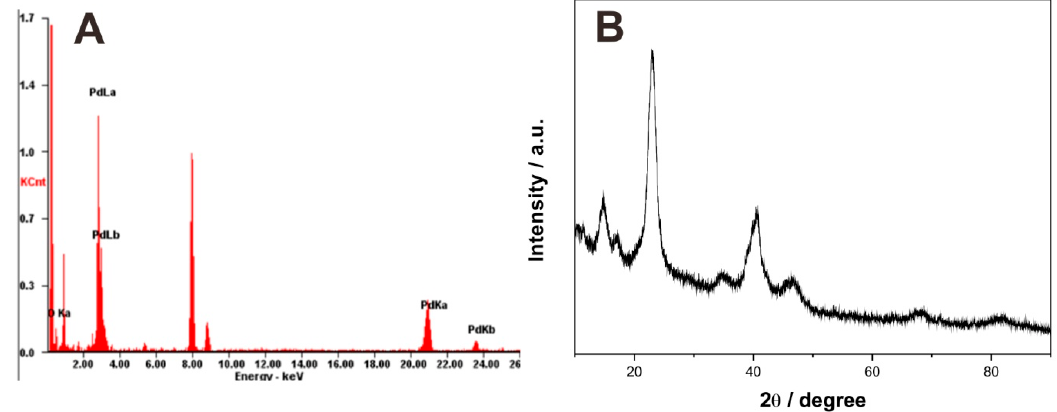
Figure 2. Energy dispersive X-ray (EDS) spectra ( A ); and X-ray diffraction (XRD) pattern ( B ) of PdBC.